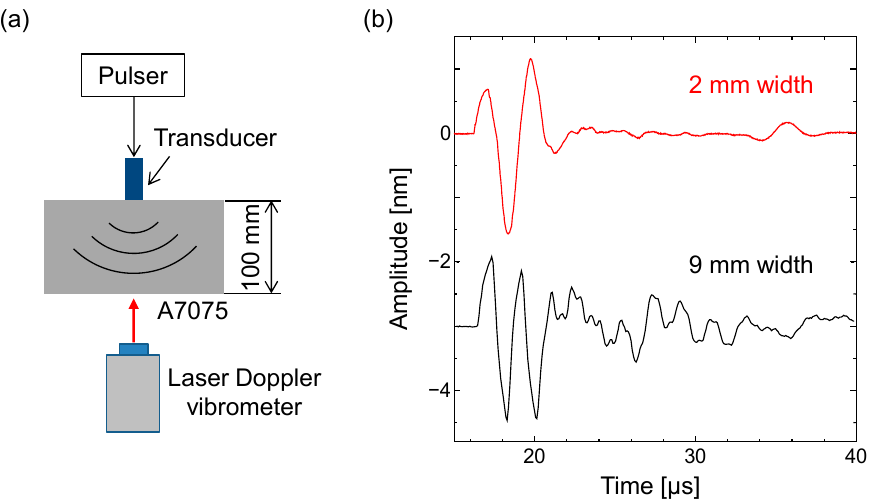
Figure 5. Transmitted waves of the 2 mm and 9 mm wide transducers. ( a ) Schematic of the experimental setup; ( b ) transmitted waves measured at the bottom of an aluminum-alloy sample using a laser Doppler vibrometer.